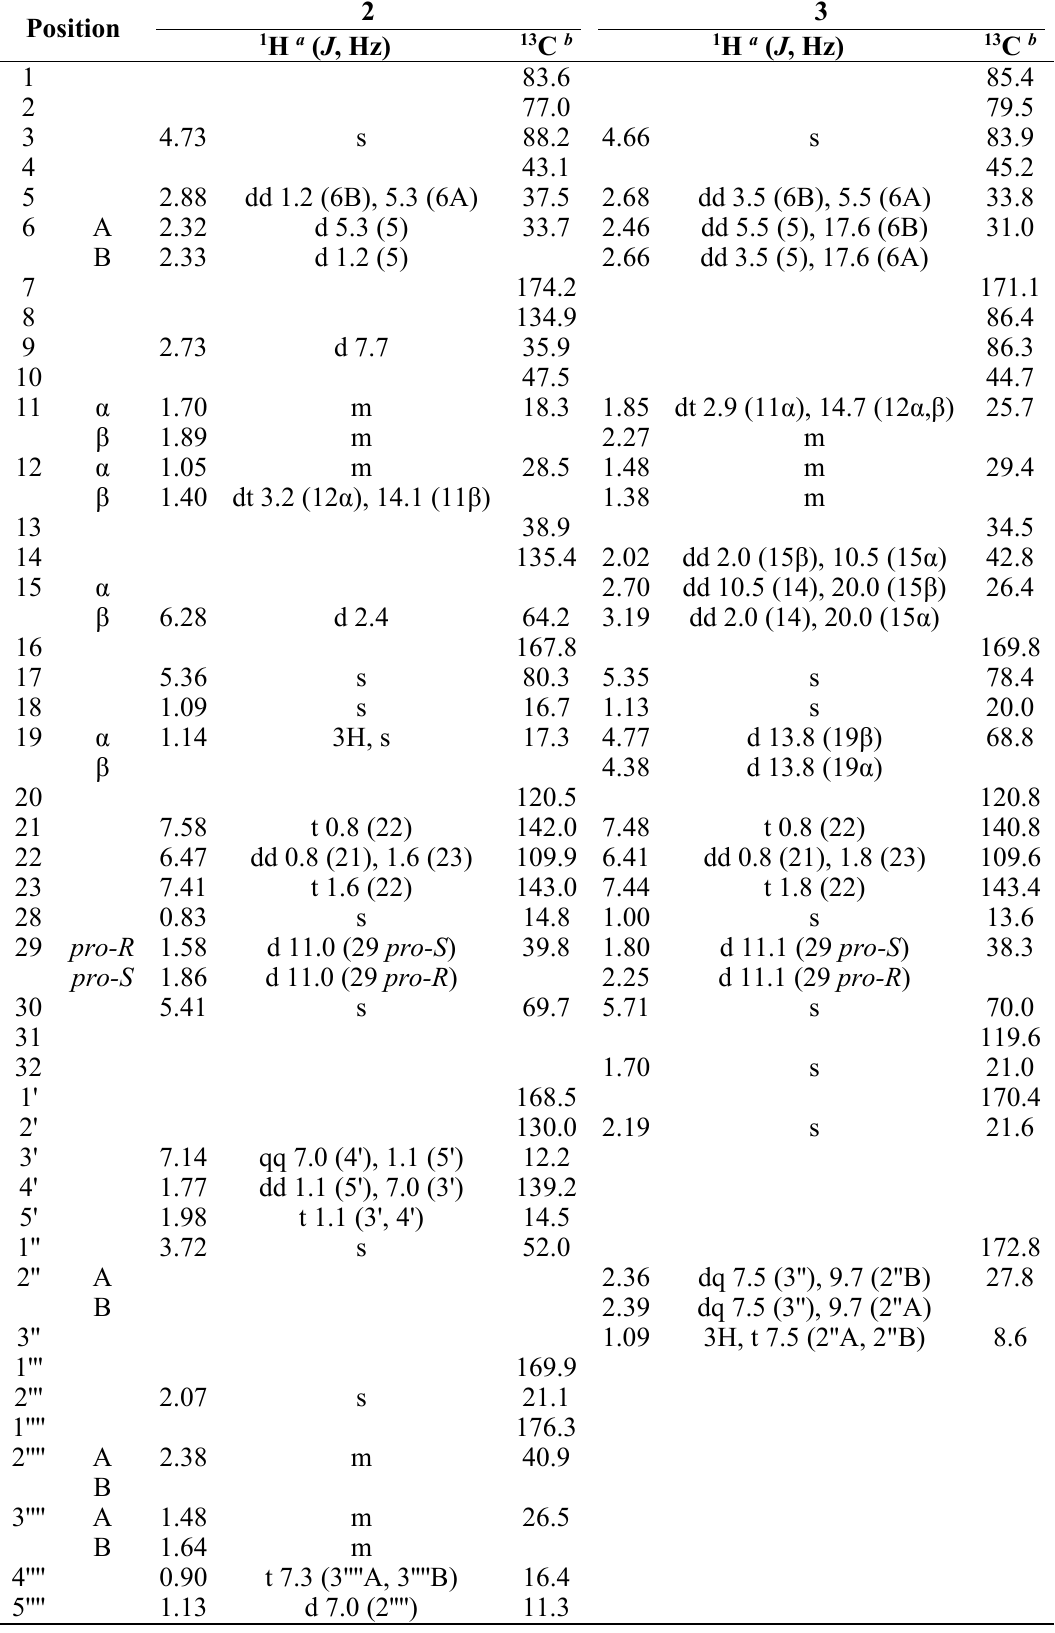
Table 2. 1 H-NMR and 13 C-NMR data for compounds 2 and 3